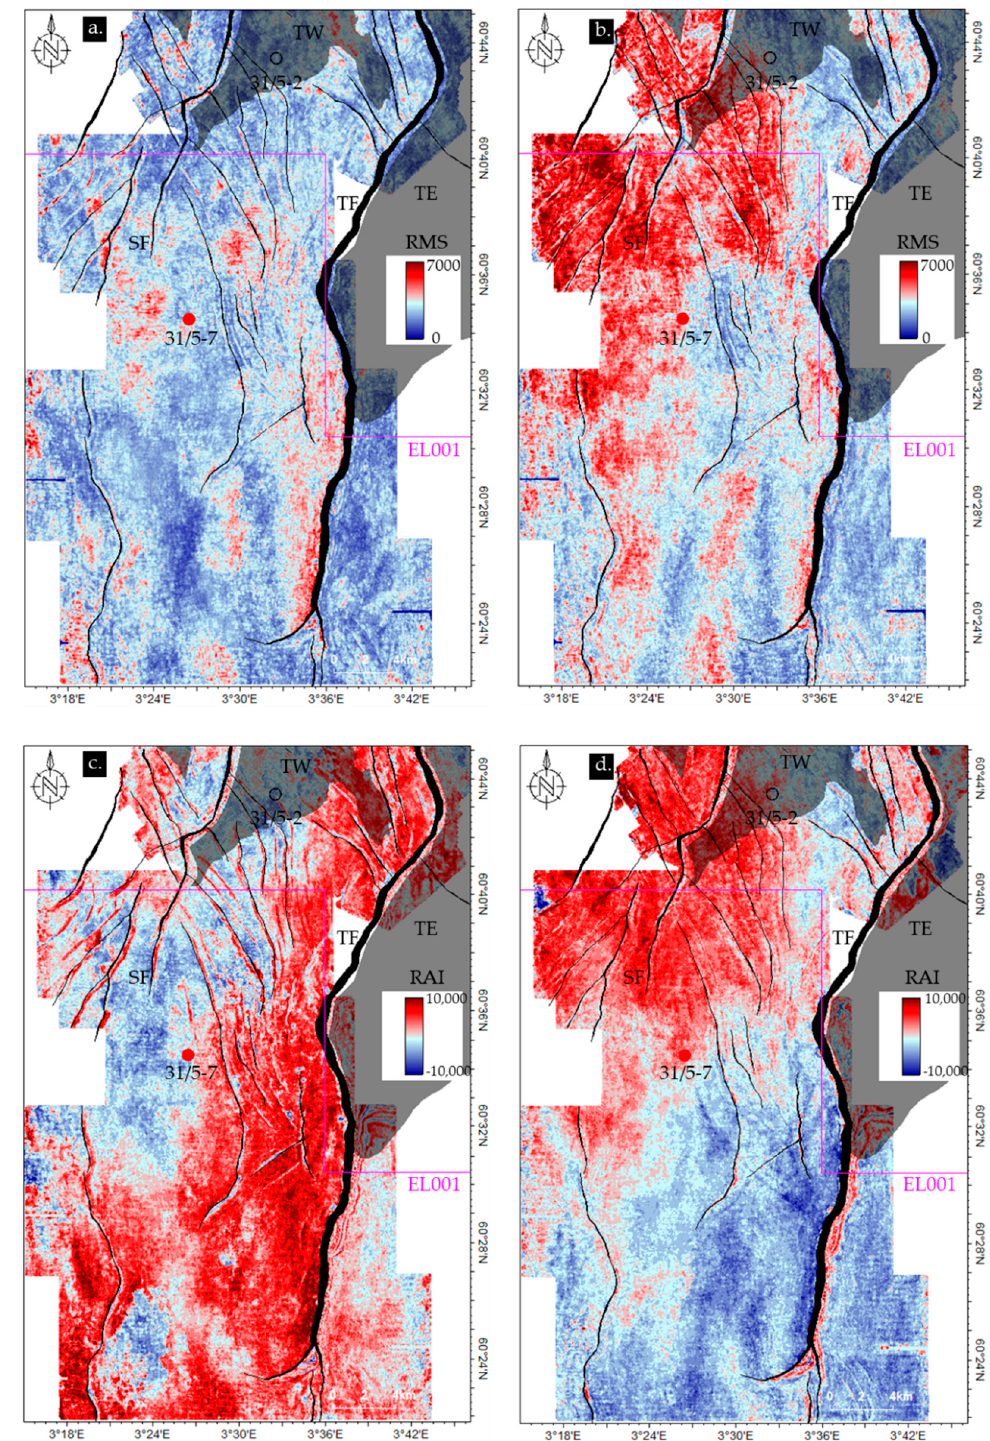
Figure 16. Variations of RMS amplitude on top of the upper Drake ( a ) and lower Drake ( b ) units are presented. Spatial variation of relative acoustic impedance (RAI) are also shown on upper Drake ( c ) and lower Drake ( d ) surfaces. Note that the faults (black), oil and gas fields (dark grey shaded polygons), the CCS license (EL001), and the proposed injection well (31/5-7) are also shown. Seismic Inverted Properties Similar to the RMS, the relative acoustic impedance (RAI) attribute map can repre- Lateral distribution of the volume of shale ( V sh ) and elastic brittleness indices (EBI) sent the lateral impedance variation. Moreover, a sign of the impedance value indicated were assessed. Both the shaliness and brittleness properties are indicators of the the information about the layer above. The impedance variation trend in the LD is similar